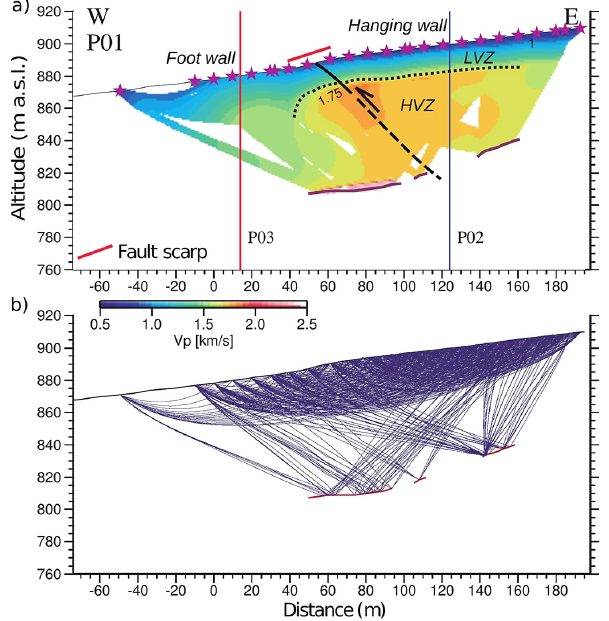
Figure 5. Results of seismic profile P1. (a) Final velocity model including the inverted reflector (blue line). Stars represent shot po- sitions. Zero distance represents position of the first geophone along the profile. Solid black line represent the SRF system derived from paleoseismological studies (Vargas and Rebolledo, 2012), while dashed black lines are inferred structures related to the SRF. Dotted black line represents shallow sedimentary units. The intersections between P1 with profiles P3 and P2 are also indicated (see Fig. 2). (b) Associated ray paths.